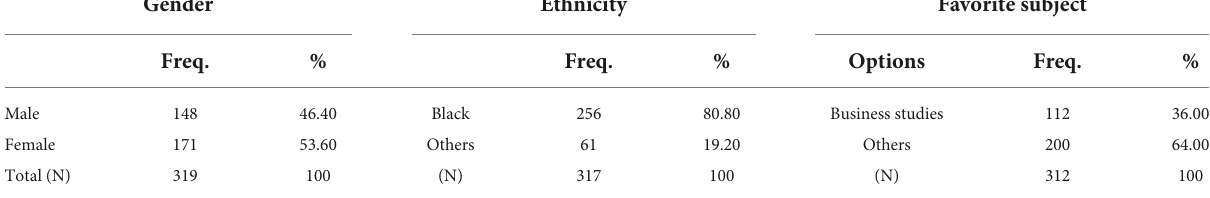
TABLE 1 Respondents’